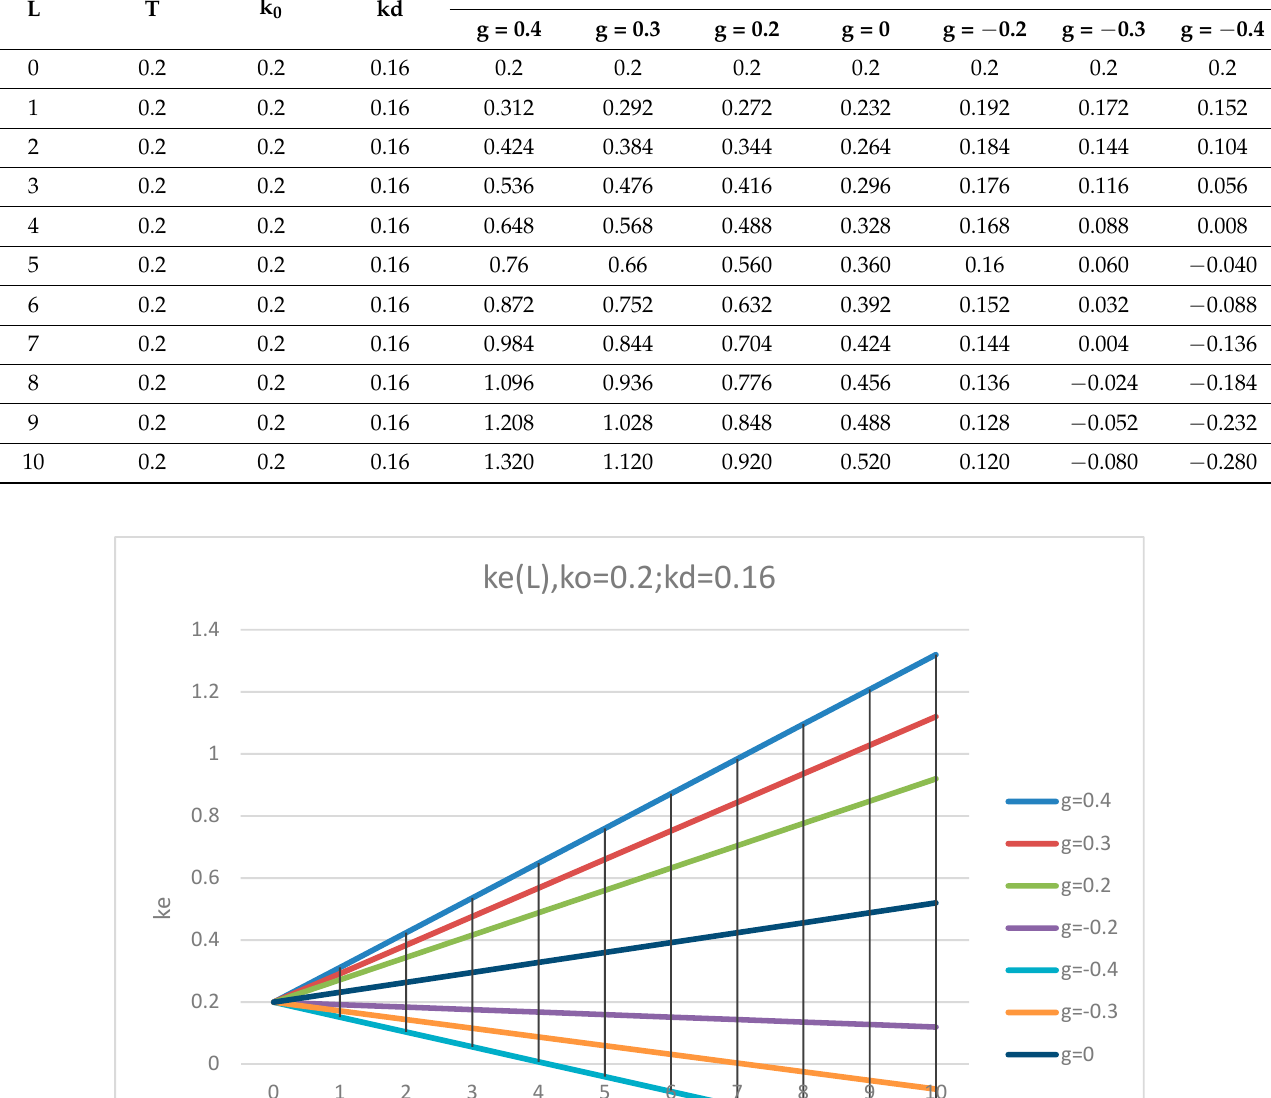
Table 7. Dependence of equity cost k e on leverage level L in Generalized Modigliani–Miller theory (GMM theory) at k 0 = 0.2 and different values of g (0; ± 0.2; ± 0.3; ± 0.4).